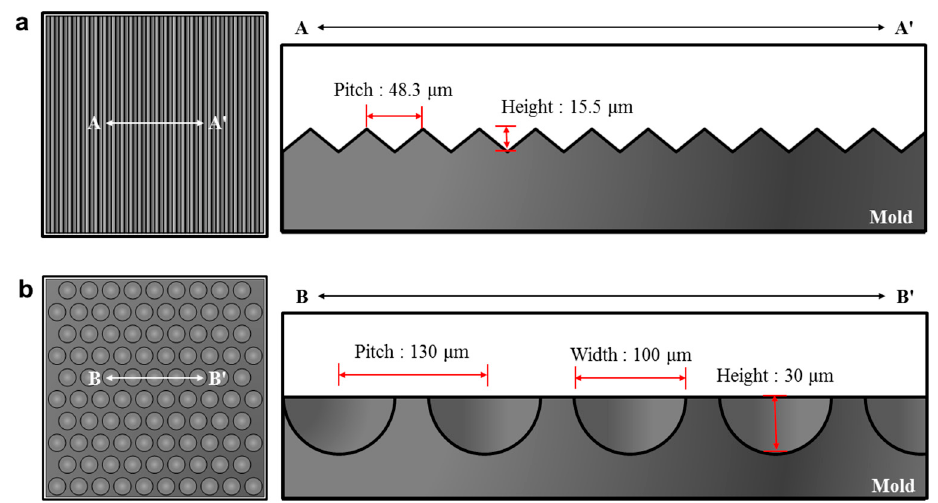
Figure 3. Dimensional configurations of micropatterned mold inserts: ( a ) prism pattern; ( b ) dot pattern.